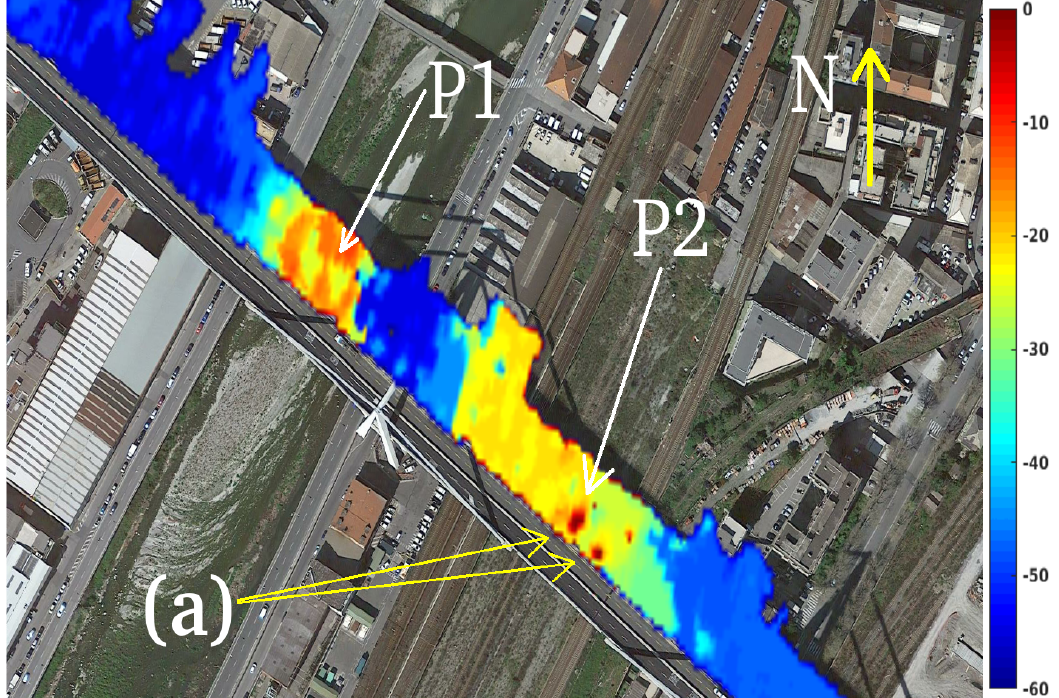
Figure 28. Vibration map of the “Morandi” bridge (details). 5 July